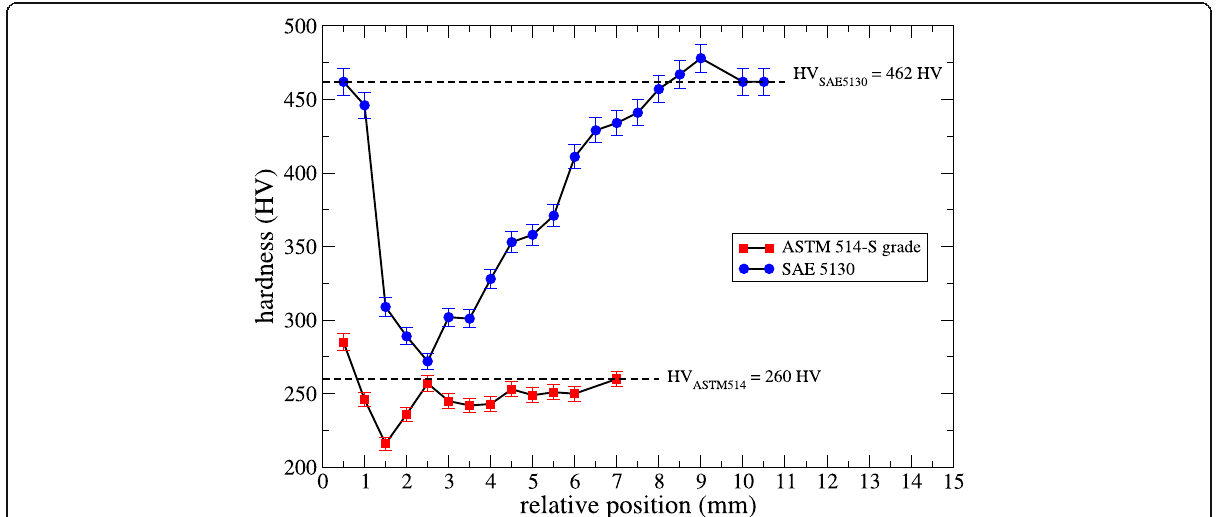
Fig. 2 Hardness and microhardness measured into the affected zone for both steels